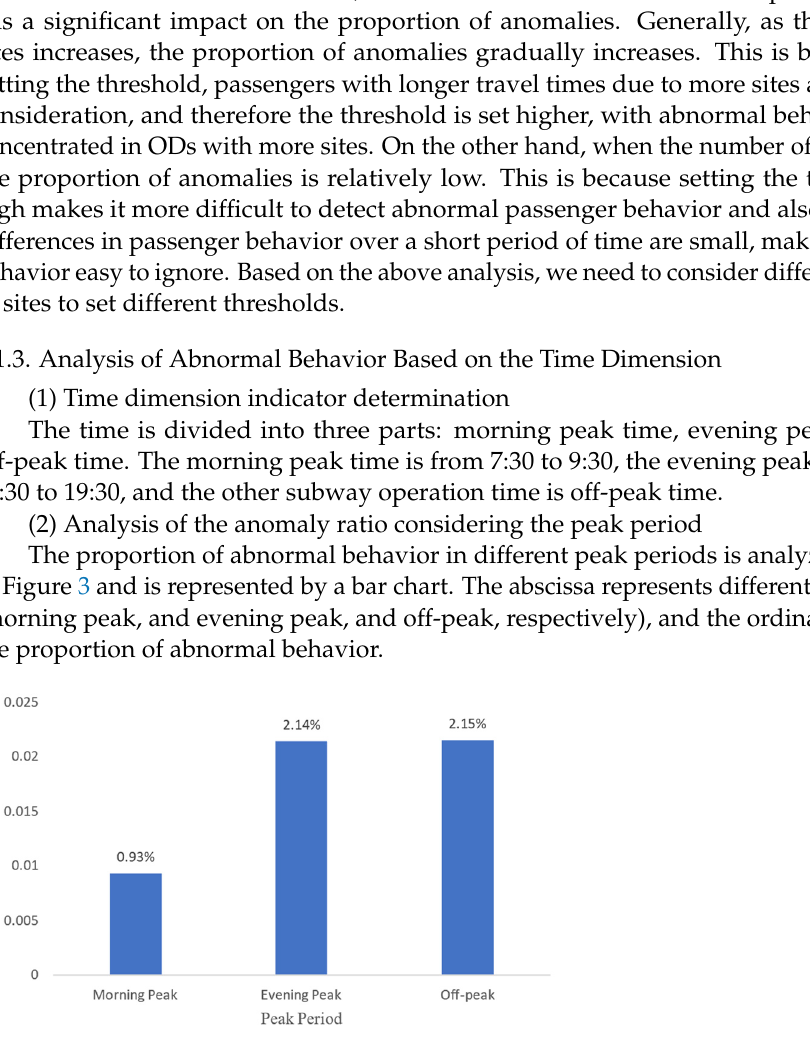
Figure 3. Percentage of anomalies in the peak